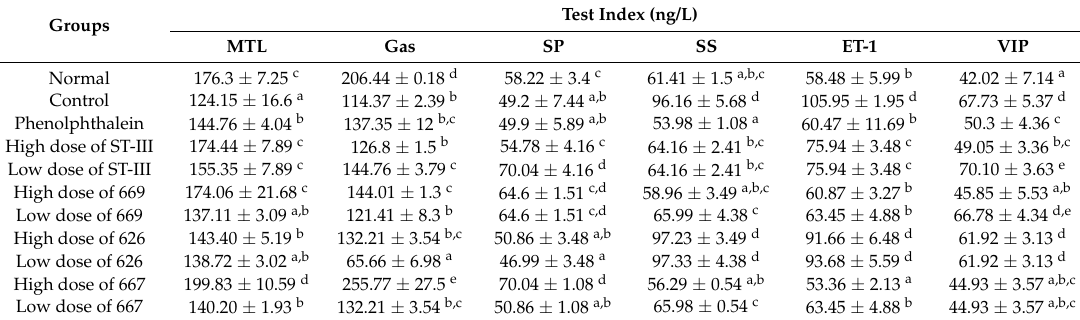
Table 5. Effects of B. adolescentis on serum parameters in a mouse model of loperamide-induced